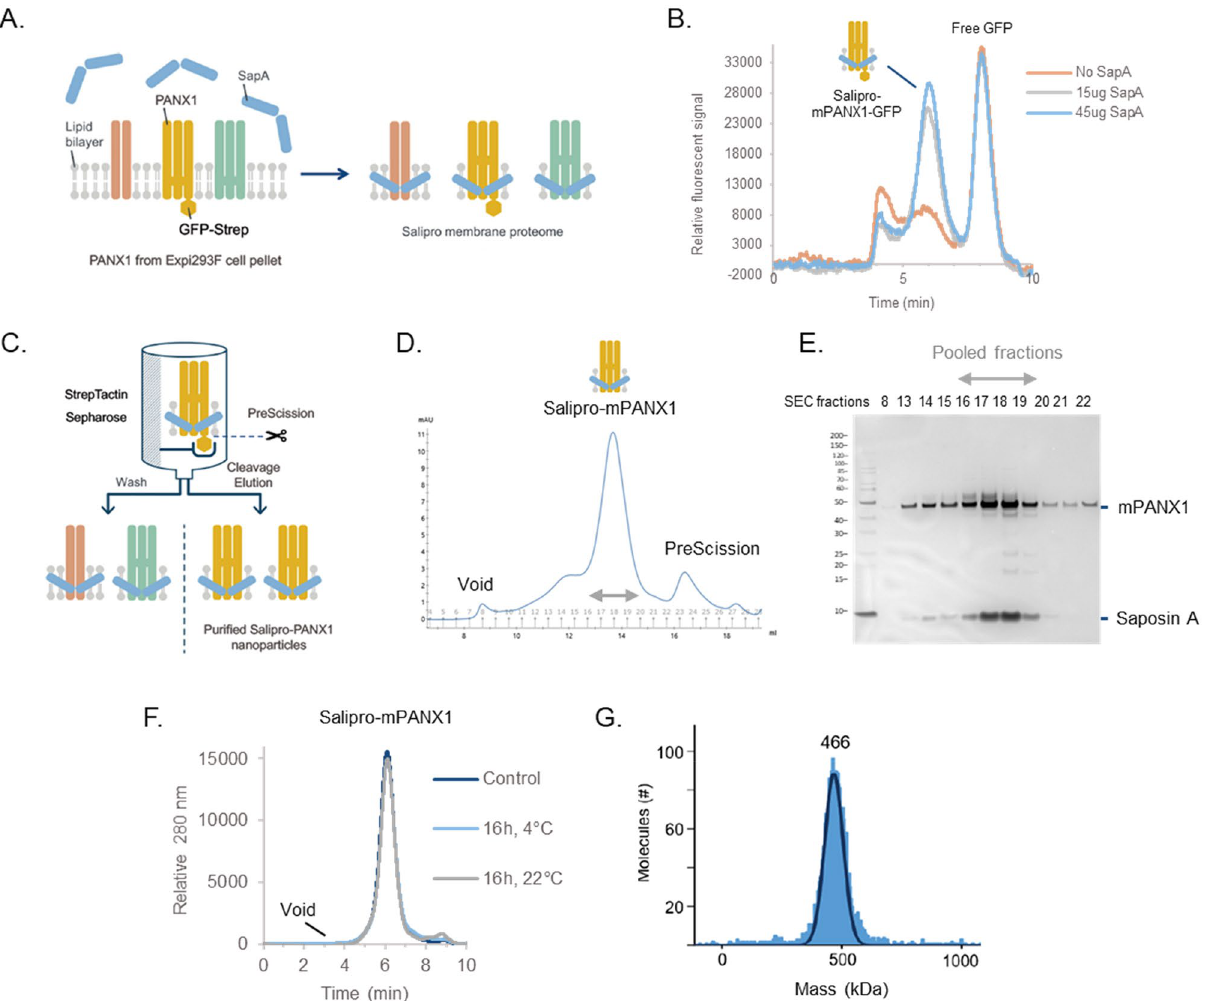
Figure 1. Salipro-mPANX1 DirectMX summary. ( A ) Schematic illustration of the DirectMX methodology. ( B ) mPANX1 expressed as a GFP fusion protein formed a homogenous population of Salipro-mPANX1-GFP nanoparticles upon addition of SapA, peaking around 6 min. ( C ) Schematic illustration of the Salipro-mPANX1 affinity purification using StrepTactin Sepharose with on-column PreScission cleavage. ( D ) Salipro-mPANX1 particle purification by preparative SEC. ( E ) SEC fraction analysis by SDS-PAGE. The unprocessed and uncropped SDS-PAGE image is shown in Supplementary Fig. S1. ( F ) Analytic SEC trace of Salipro-mPANX1 particles that were thawed and incubated for 16 h at 4 °C or 22 °C. The control sample was analyzed immediately after freeze-thawing without any further incubation. ( G ) Mass photometry confirms the presence of a homogenous population of Salipro-mPANX1 particles with an apparent nanoparticle size of 466